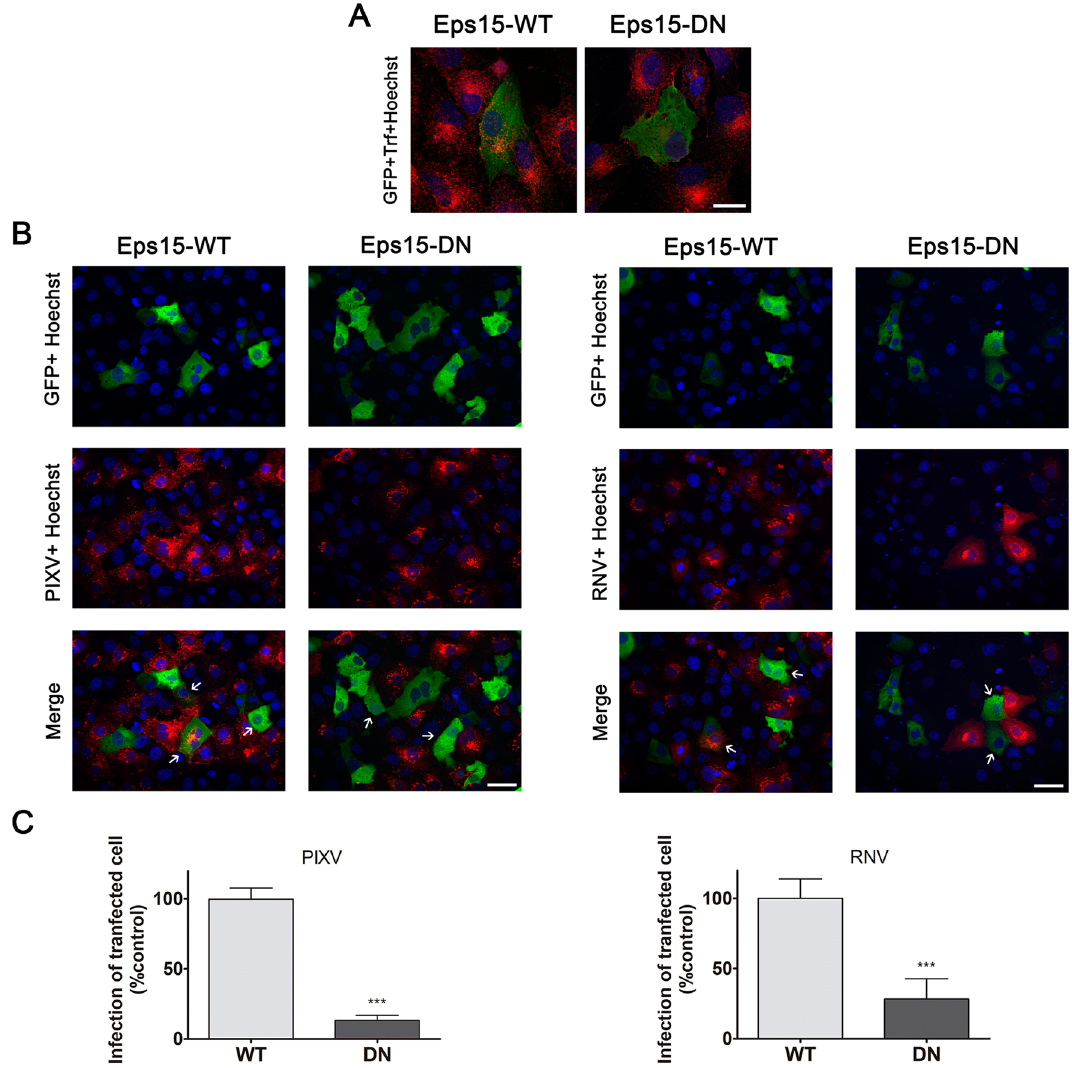
Figure 2. Inhibition of PIXV and RNV entry by transient expression of the Eps15 dominant negative mutant construct. ( A ) Representative images of cells transfected with plasmids expressing Eps15-WT or Eps15-DN (green) and incubated with TRITC-transferrin (red); nuclei (blue). ( B ) Immunofluorescence of transiently transfected cells with plasmids expressing Eps15-WT or Eps15-DN (green) and infected with PIXV or RNV (red) at MOI 10 after 8 hpi (arrow); nuclei (blue). ( C ) Percentages of transfected and infected cells. More than 300 transfected cells were screened in each case. Data represent the mean ± SD from 3 independent experiments. Significance was calculated by Student’s t test, with p value ≤ 0.05 considered as statistically significant. *** p < 0.001. Scale bar: 20